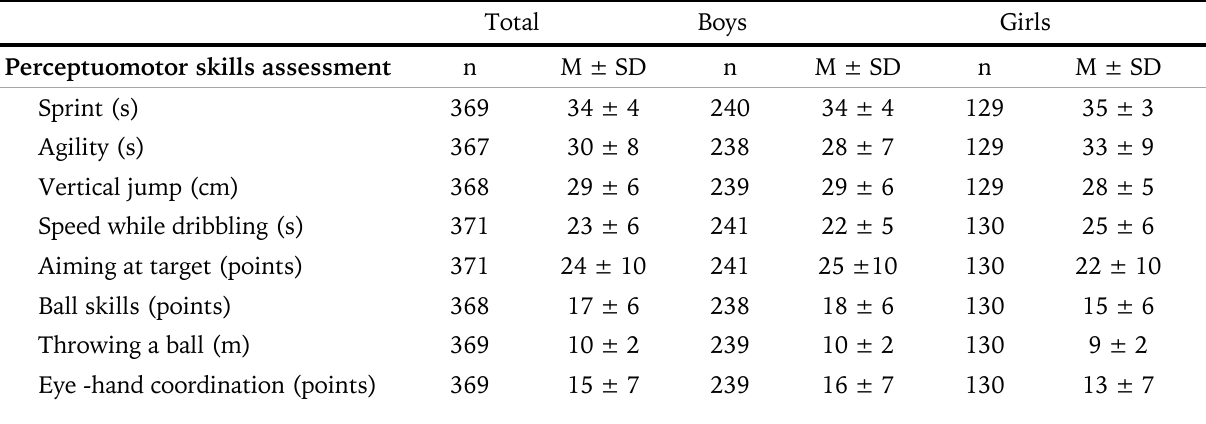
Data are frequencies (and percentage of the total sample (%)) except for standing height, weight and BMI. These latter variables are presented in means ± standard deviations. Table 3. Outcomes perceptuo-motor skills assessment and training